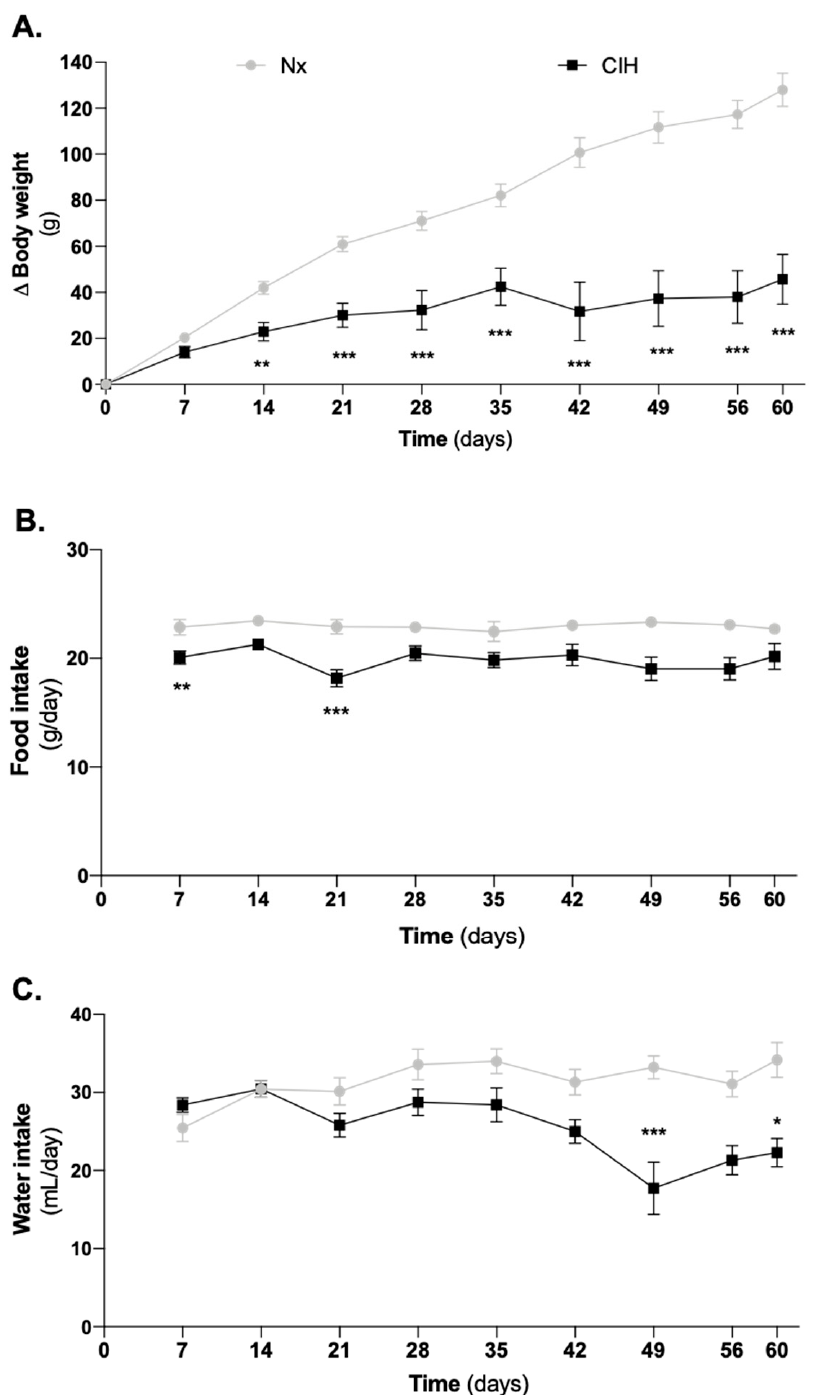
Figure 1. Impact of CIH on ( A ) the animals’ growth curves for body weight, ( B ) food intake, and ( C ) water intake. The CIH animals showed ( A ) a disruption of the growth curve for body weight, ( B ) a slight decrease in food consumption particularly in the period of HTN development, and ( C ) a decrease in drink consumption in long-term CIH. Data are presented as variation of body weight from baseline. Two-way ANOVA with Bonferroni’s multiple comparison test; comparison Nx vs. CIH: * p < 0.05; ** p < 0.01; *** p < 0.001. Number of animals per group: Day of study ( n for Nx; n for CIH): D7 (33; 31), D14 (25; 26), D21 (20; 20), D28 (12; 14), D35 (12; 14) and D42 to D60 (6; 6). CIH: chronic intermittent hypoxia; Nx: normoxia.